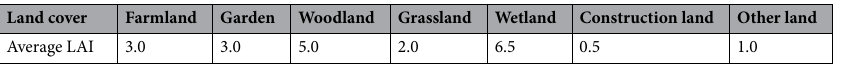
Table 2. Average LAI of land cover type (m 2 /m 2